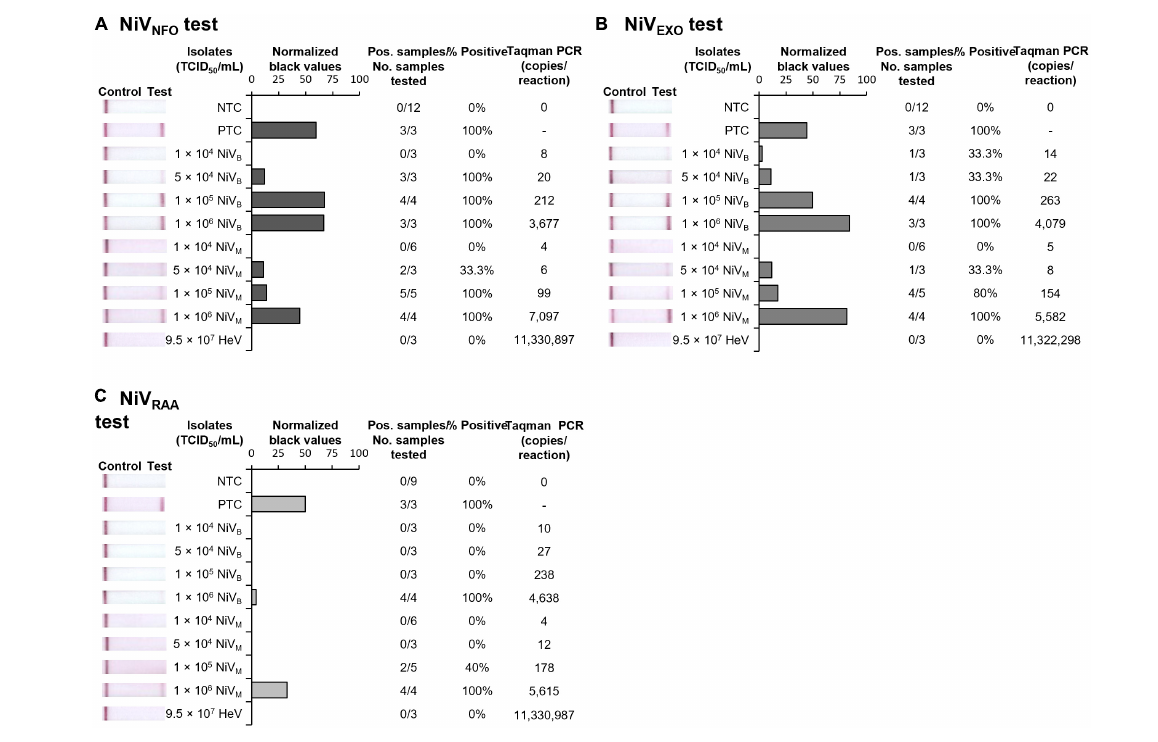
FIGURE4 Sensitivity and specificity of three rapid NiV tests. Sensitivity testing used rapidly processed NiV B and NiV M strain isolates for RT-nfoRPA-LFD (A) , RT-exoRPA-LFD (B) , and RT-RAA-LFD (C) assays compared to TCID 50 /mL determined by immunolabeling assays and copies/reaction determined by comparative Taqman PCR. Images of lateral flow strips with two bands (control and test band) indicates the sample is positive for NiV, and single control band indicates a valid reaction with negative sample. Photograph of lateral flow strips with control bands (all samples) and test bands (positive samples) compared to titer of rapidly processed serially diluted NiV isolate (TCID 50 /mL) and no template control (NTC) (left). Normalized pixel density (normalized black values) from the lateral flow test strip displayed (middle). Positive samples compared to number of samples tested at that dilution was used to calculate the percentage of positive tests performed at that dilution